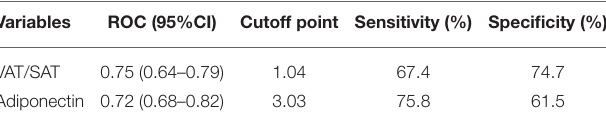
TABLE 4 | ROC curve for predicting ICAS and cutoff points for maximum sum of sensitivity and specificity.